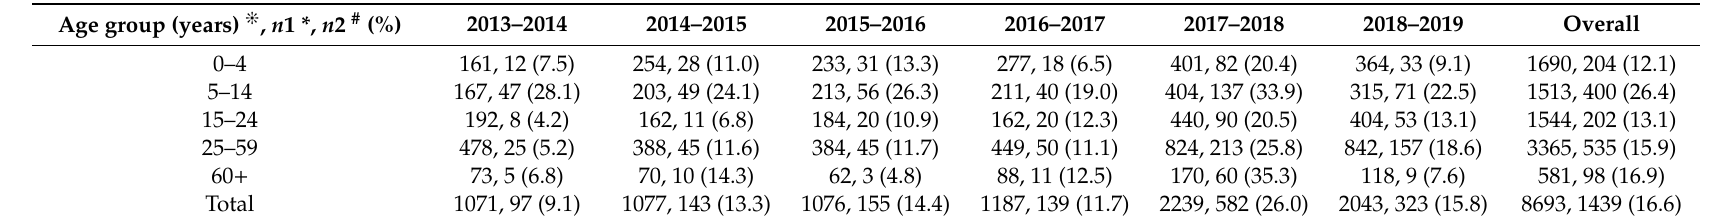
Table 2. Age-specific influenza positive rates in di ff erent surveillance years, Yichang, Hubei, 2013–2019. Age group (years) (cid:106) , n 1 *, n 2 #